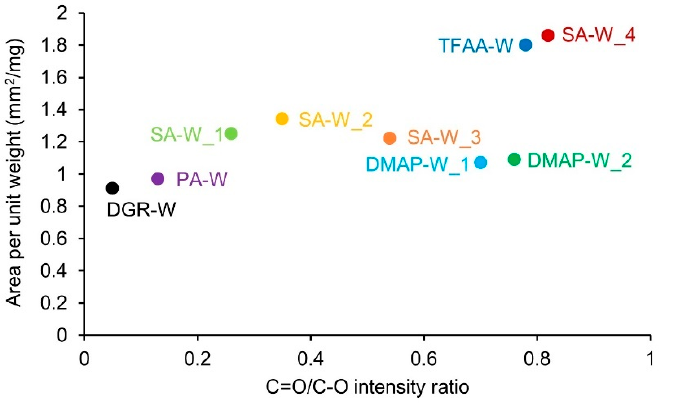
Figure 7. Area per unit weight of the pressed wood specimens, showing the ratio of the IR peak intensity derived from the C=O groups to that of C–O stretching